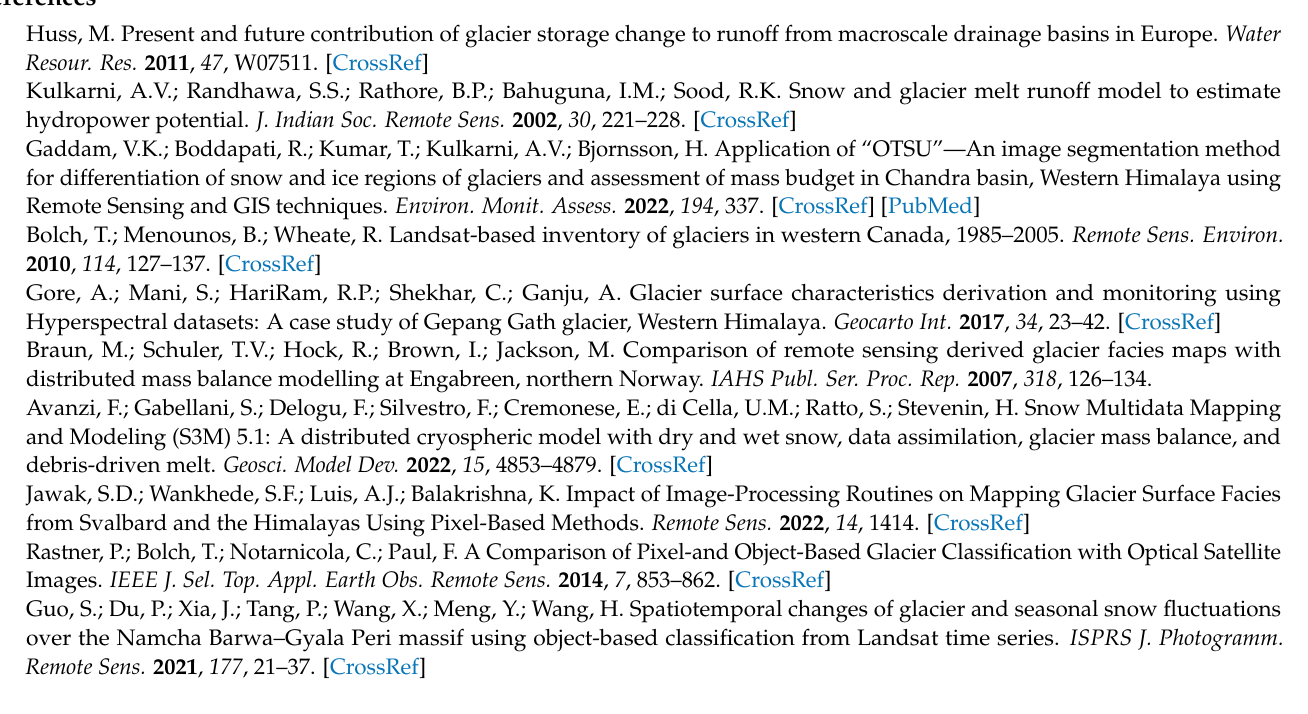
are highlighted in Table 2. Table S4: Measures of accuracy used in the current study. TP: samples are those that are in the positive class and are correctly classified, TN: samples that are correctly classified as negative, FP: samples that are not truly of the positive class but are incorrectly mapped as positive. FN: samples that are mapped as negative when they are positive. Sheet S1: Precision, recall, specificity, F1 score. Overall accuracy (OA), error rate (ER) for each processing scheme, rule sets, facies, and both study